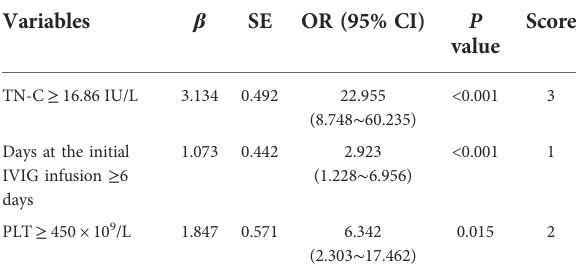
TABLE 4 Logistics regression analysis and the simple scoring system for predicting CALs.